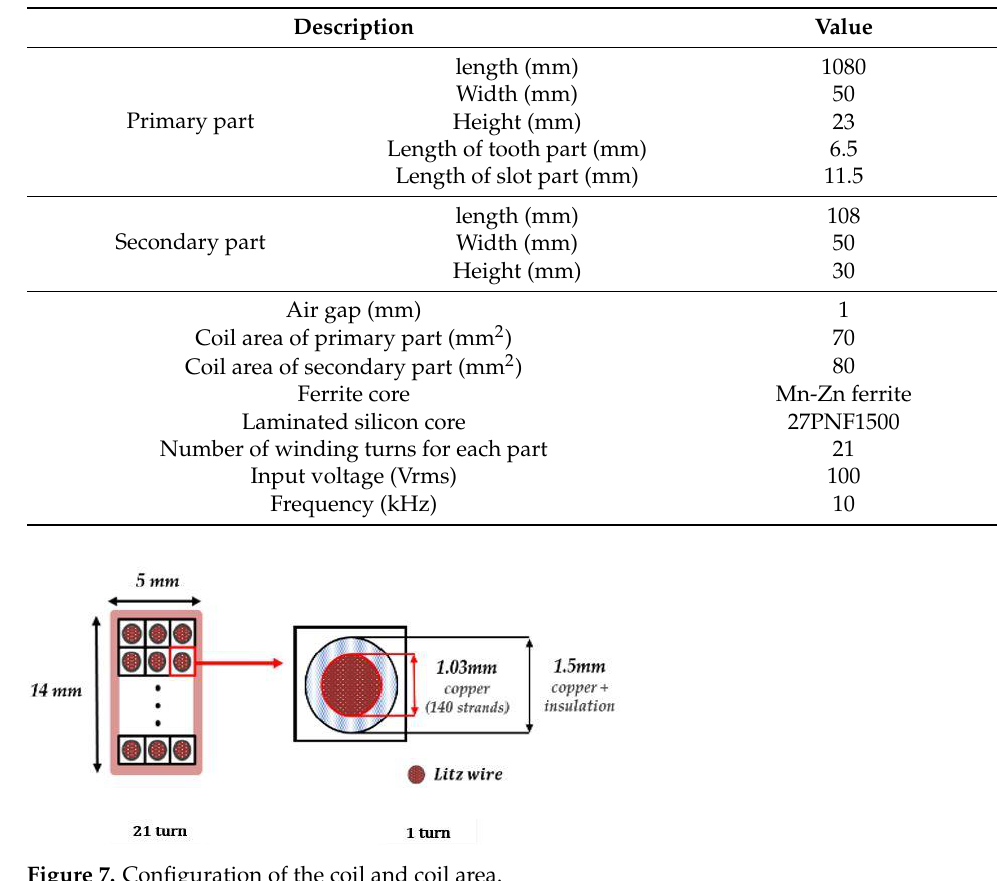
Table 1. Dimensions and specification of a wireless power transfer device.